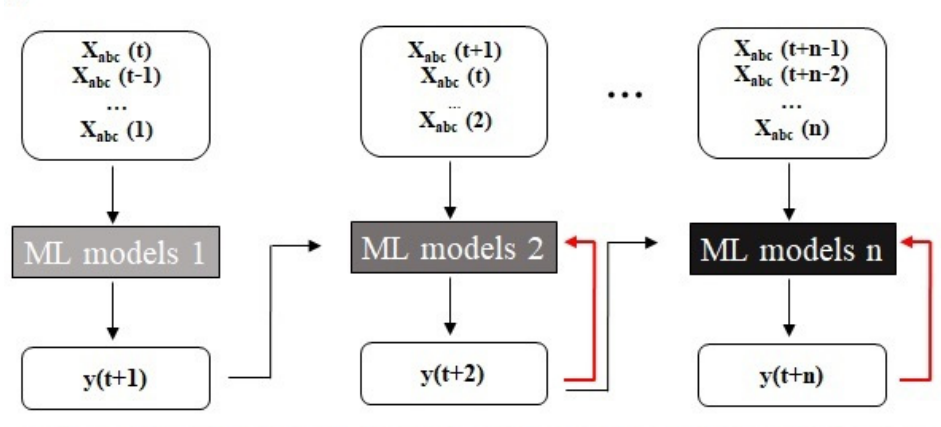
Figure 2. Fundamentals of the ( a ) multi-step ahead and ( b ) 1-step ahead with retraining methods [21].